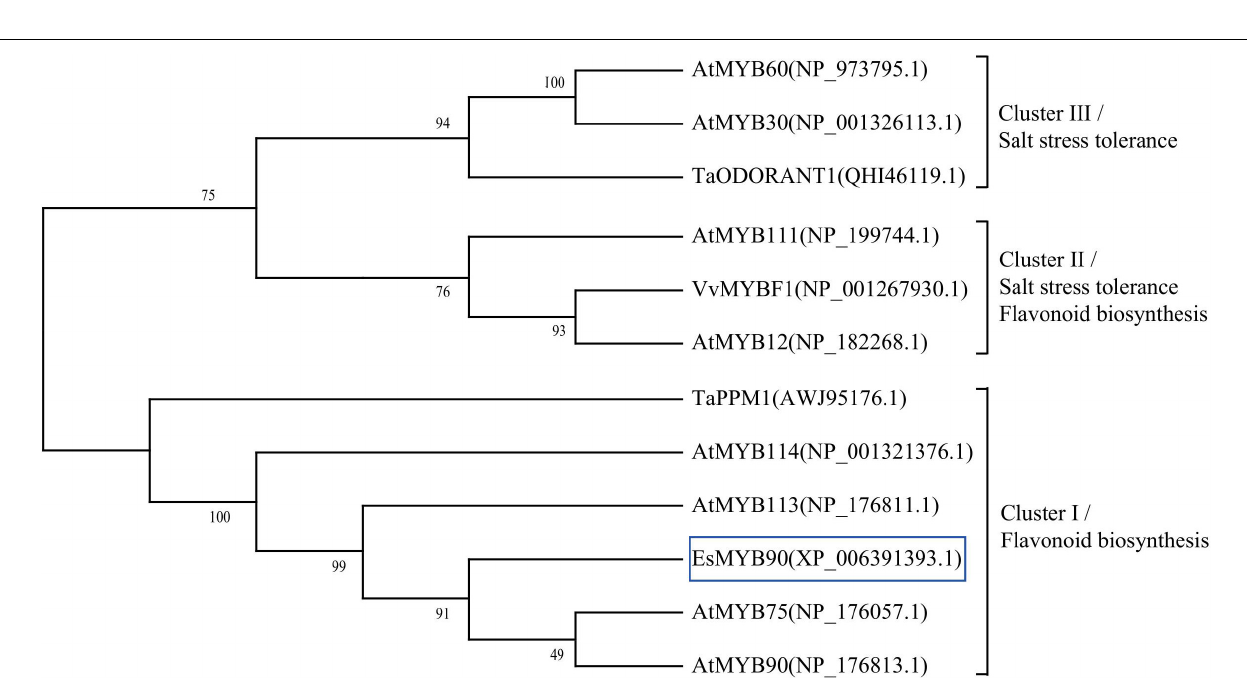
Frontiers in Plant Science |